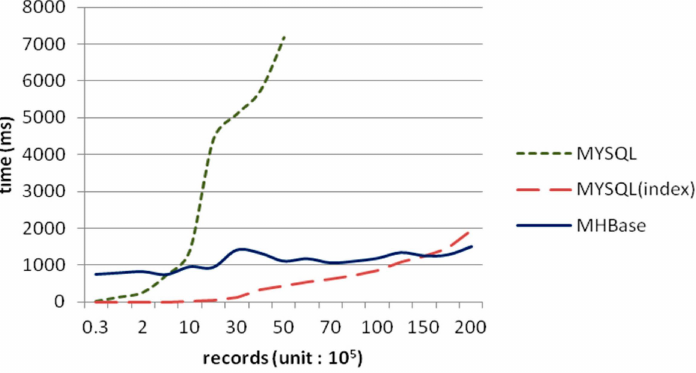
Figure 6. Query time in weather dataset.